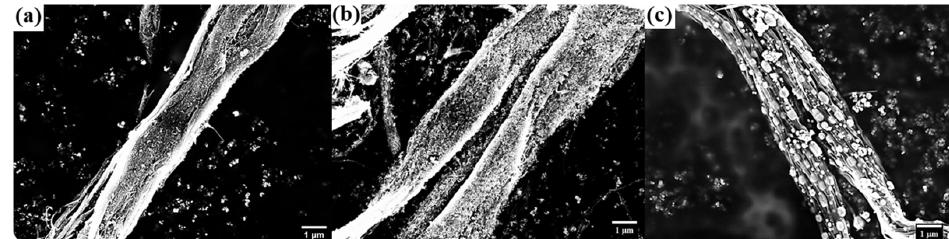
Figure 3. SEM imaging of CNT bundles at 10k× magnification: ( a ) untreated CNT bundles; ( b ) activated bundles; ( c ) Eu:Y 2 O 3 -CNT bundles.